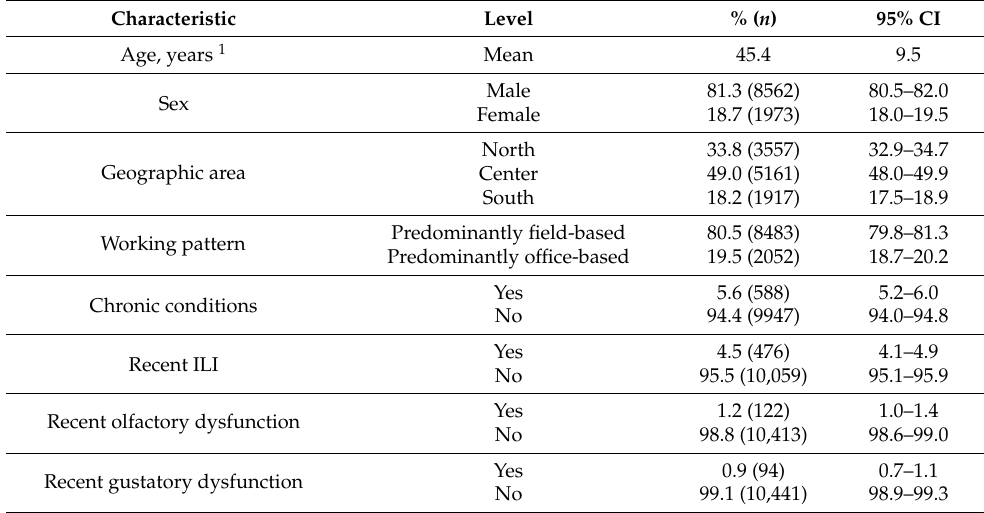
Table 1. Characteristics of the study participants ( n =